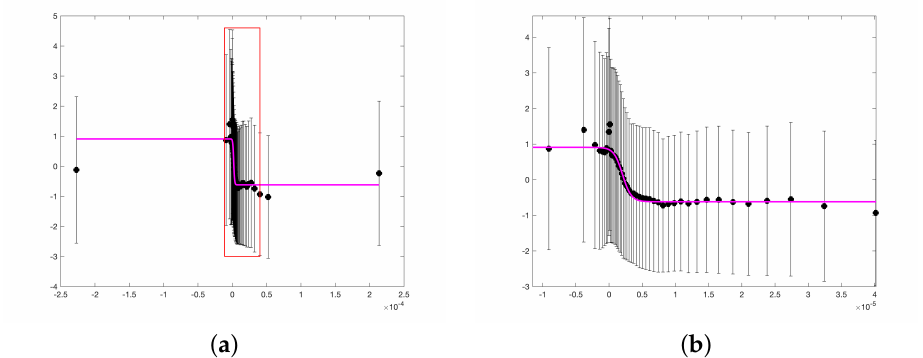
Figure 6. Same as Figure 5, but depending on the derivative of the bottom density in the direction of (cid:12) (cid:12) the slope ∂ρ . Panels ( a , b ) contain the closest functional dependence (cid:12) ∂ (cid:126) n H